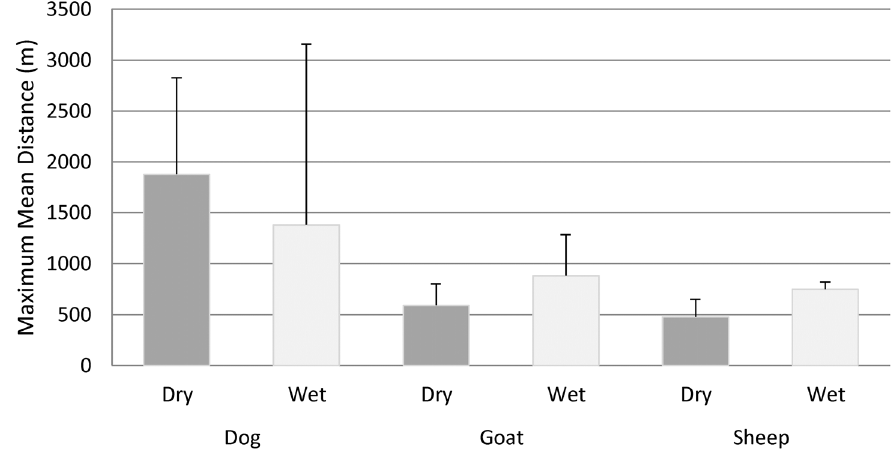
Figure 2. Mean maximum distance traveled from home (m) in dry and wet seasons by domesticated animal species in Mwamgongo village, Tanzania.